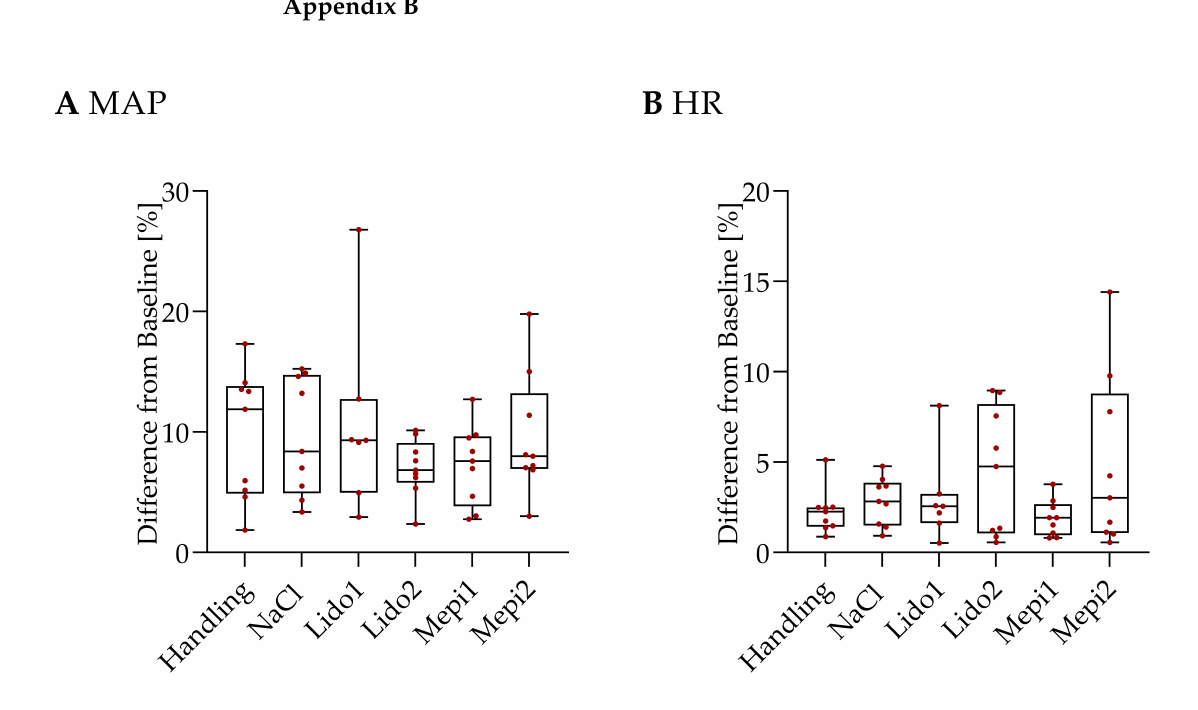
Figure A2. Interdigital pinch. Percent change in ( A ) mean arterial blood pressure (MAP) and ( B ) heart rate (HR) during the interdigital pinch for the adjustment of anesthesia depth. Values shown are means ±